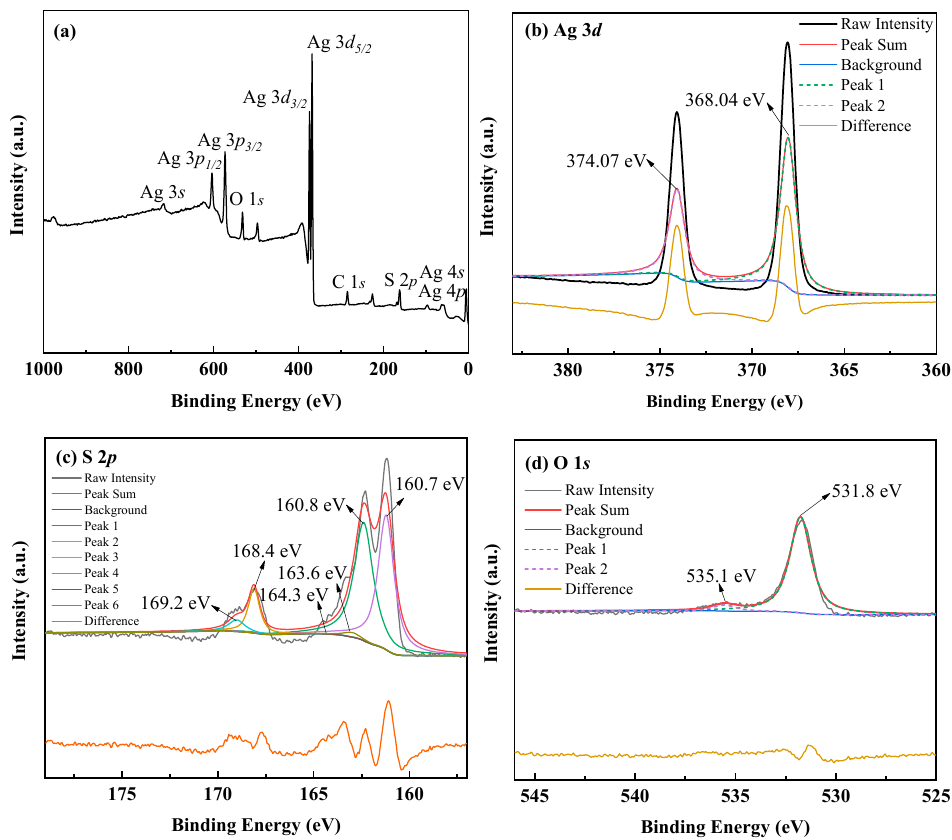
Figure 4. Deconvoluted XPS spectra for photoproducts ( a ) survey spectrum; ( b ) Ag 3 d spectrum; ( c ) S 2 p spectrum; ( d ) O 1 s spectrum ([Ag] = 500 mg/L, [S 2 O 32 − ] = 0.1 mol/L, 298 K, uncontrolled pH).